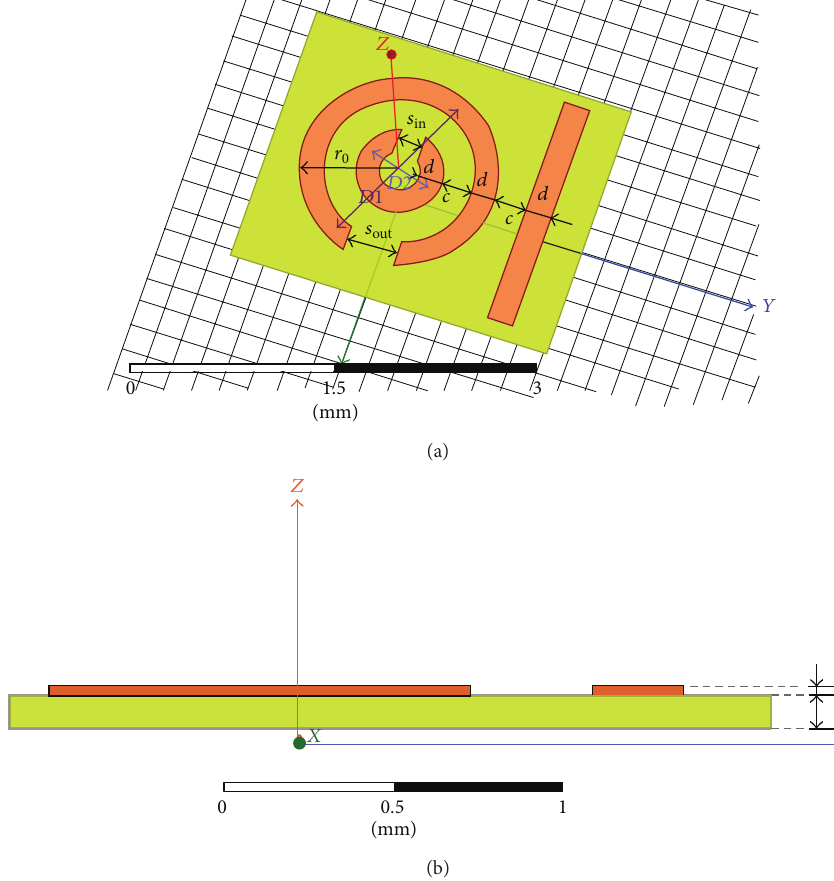
Figure 2: SRR 𝑟 0 = 0.75 mm, width 𝑑 = 0.18 mm, spacing between the two rings 𝑐 = 0.24 mm, thickness of the SRR 𝑡 𝑚 = 0.035 mm, and the = 0.4 mm and of the inner ring 𝑠 = 0.2 mm; the wire has 0.2 mm of width and 1.8 mm of length. split of the outer ring 𝑠 out in